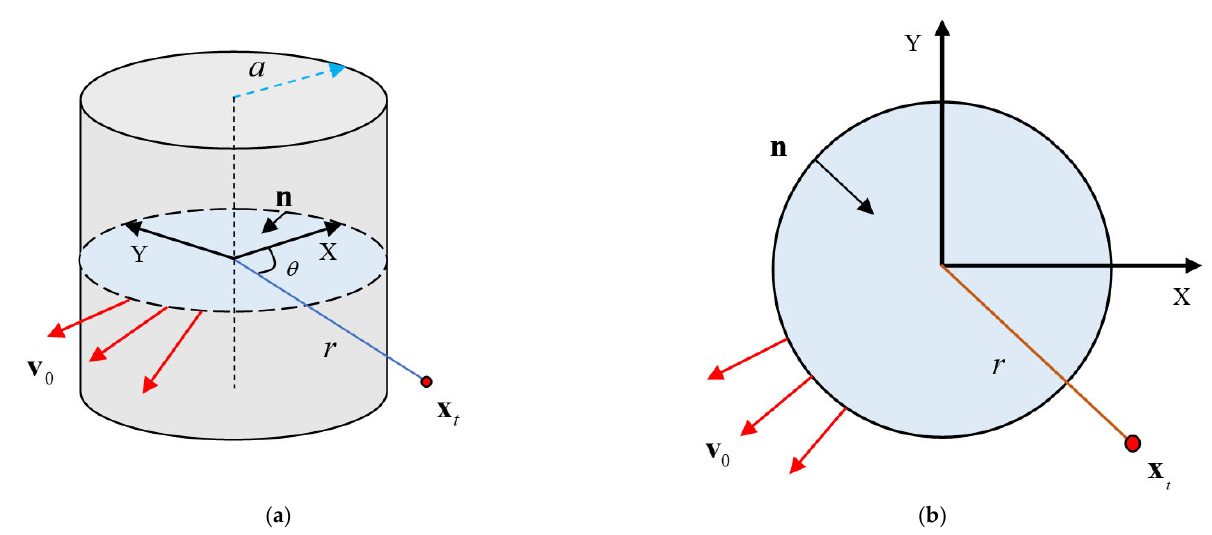
Figure 1. Infinite pulsating cylinder: ( a ) a pulsating cylinder; ( b ) simplified model.